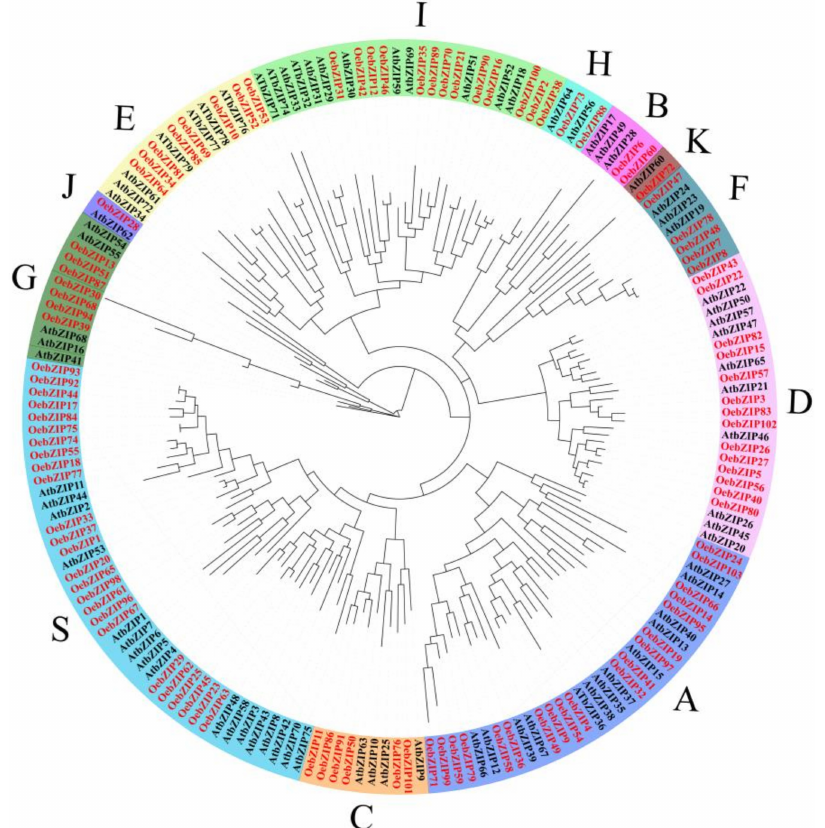
Figure 1. Phylogenetic tree of bZIP proteins from Arabidopsis and olive were built by the ML method. The bZIP genes from olive and Arabidopsis are marked in red and black, respectively. Plant bZIP members were divided into 12 subgroups (A~K, S). Di ff erent color blocks represent di ff erent subgroups. The bootstrap was set